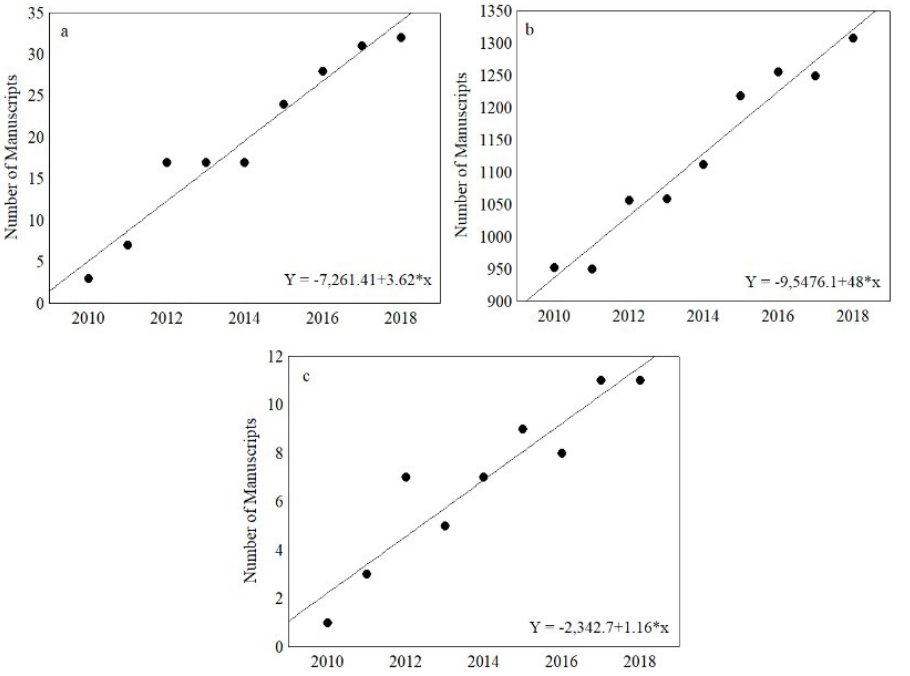
Figure 1. Temporal trends in the number of manuscripts referencing (a) Kruk et al. (2010), (b) the total world production on freshwater phytoplankton between 2010 and 2018, and (c) studies that applied the MBFG classification. * Multiplication sign.